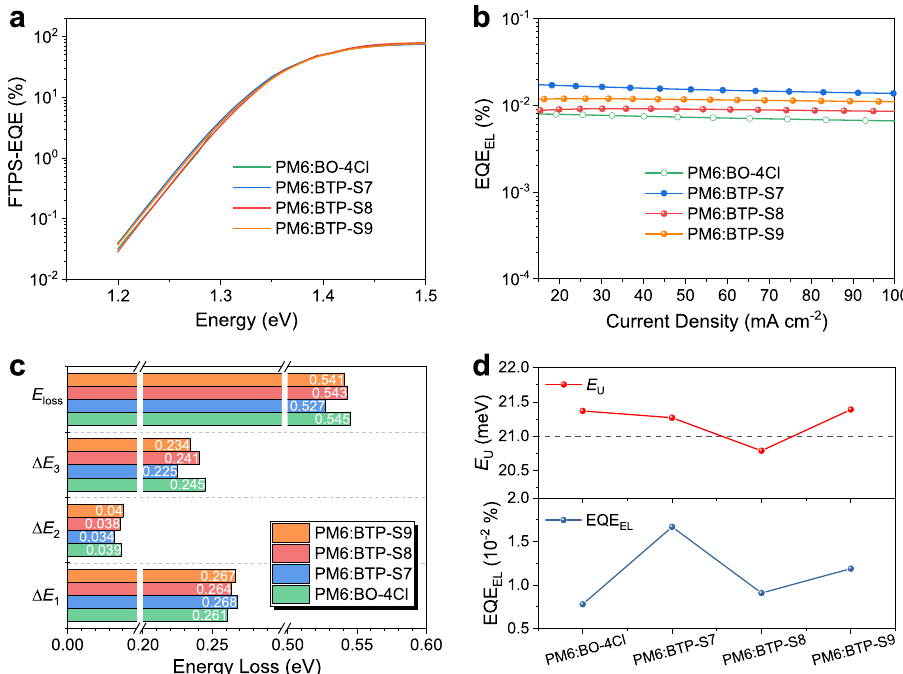
Fig. 3 Energy loss analysis. a FTPS-EQE curves of OPVs based on PM6:BO-4Cl, PM6:BTP-S7, PM6:BTP-S8, and PM6:BTP-S9 blends. b EQE EL of OPVs at various injected current densities. c Comparison of radiative and nonradiative energy losses. d Variations of E U and EQE EL in OPVs based on PM6:NFA blends. Table 2 Detailed energy losses of OPVs based on PM6:BO-4Cl, PM6:BTP-S7, PM6:BTP-S8, and PM6:BTP-S9